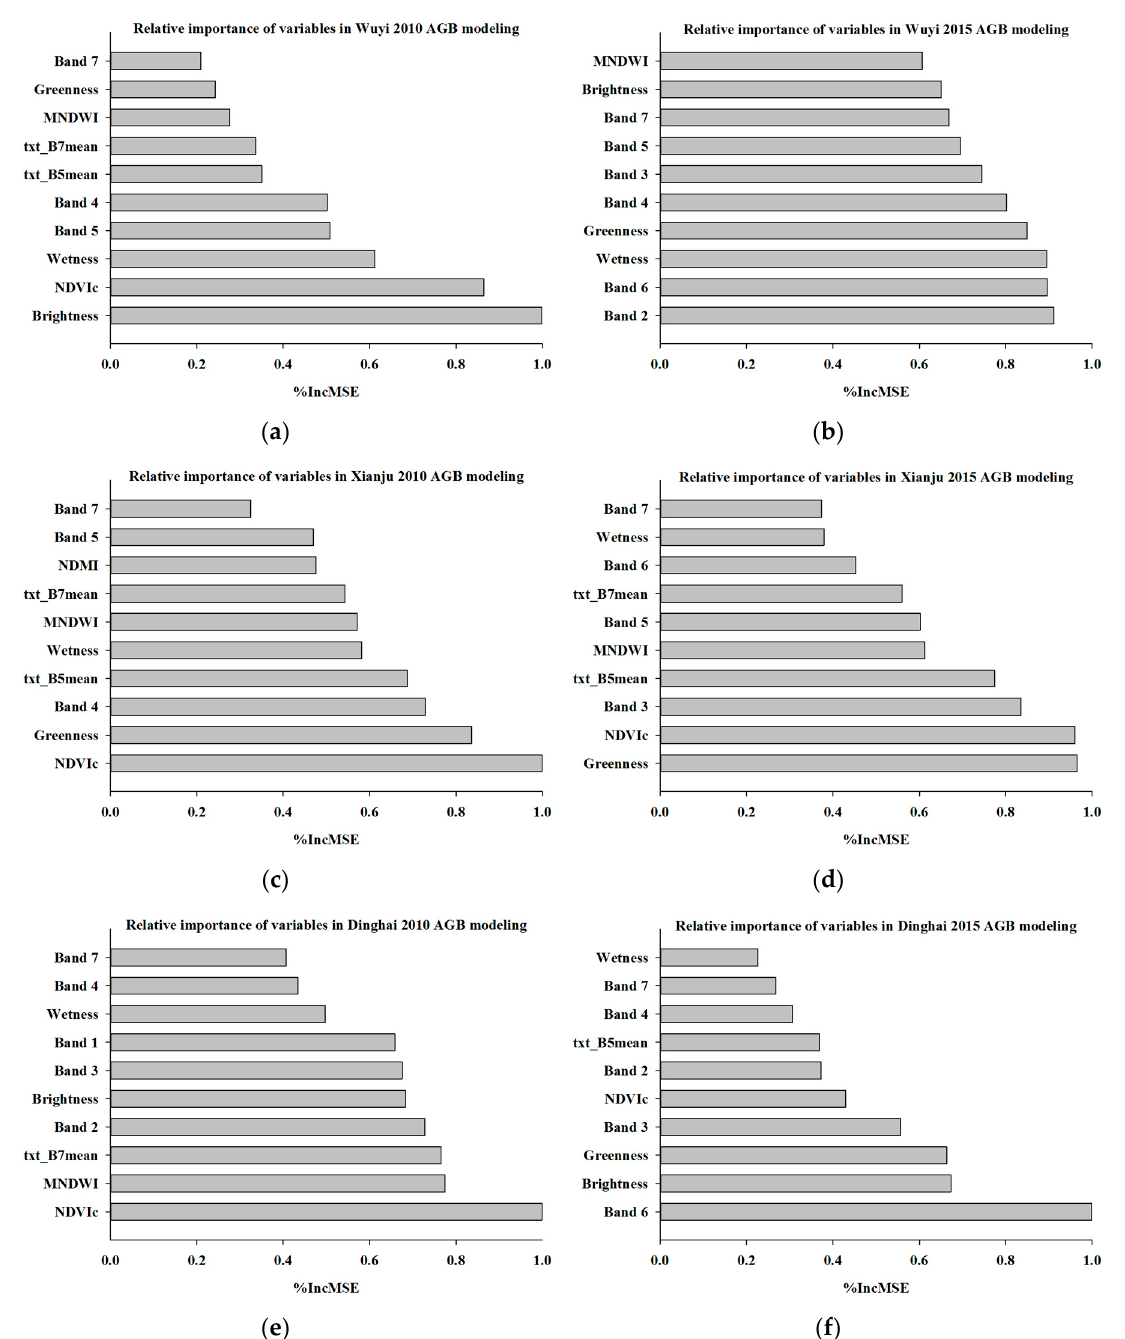
Figure 3. The relative importance of the top 10 variables in three regions: ( a ) relative importance of variables in Wuyi 2010 AGB modeling; ( b ) relative importance of variables in Wuyi 2015 AGB modeling; ( c ) relative importance of variables in Xianju 2010 AGB modeling; ( d ) relative importance of variables in Xianju 2015 AGB modeling; ( e ) relative importance of variables in Dinghai 2010 AGB modeling; ( f ) relative importance of variables in Dinghai 2015 AGB modeling. AGB: aboveground biomass.